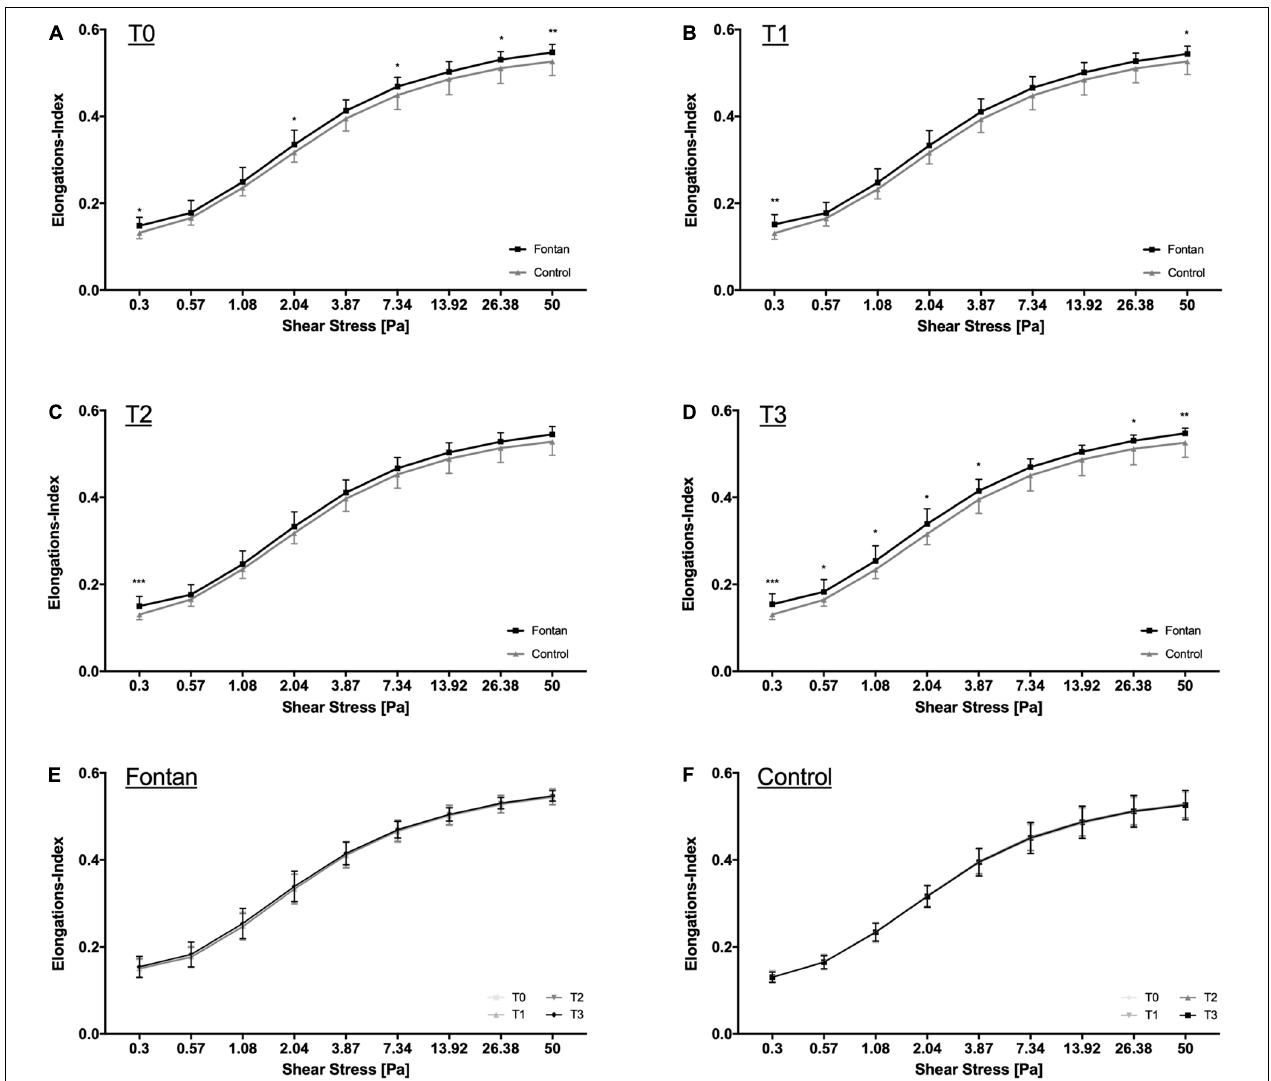
FIGURE 3 | RBC deformability measurements. RBC deformability for (A) T0, (B) T1, (C) T2, and (D) T3 was significantly higher in Fontan patients compared to healthy controls. Within group comparison of RBC deformability revealed no change in deformability during intervention for (E) Fontan patients and (F) healthy